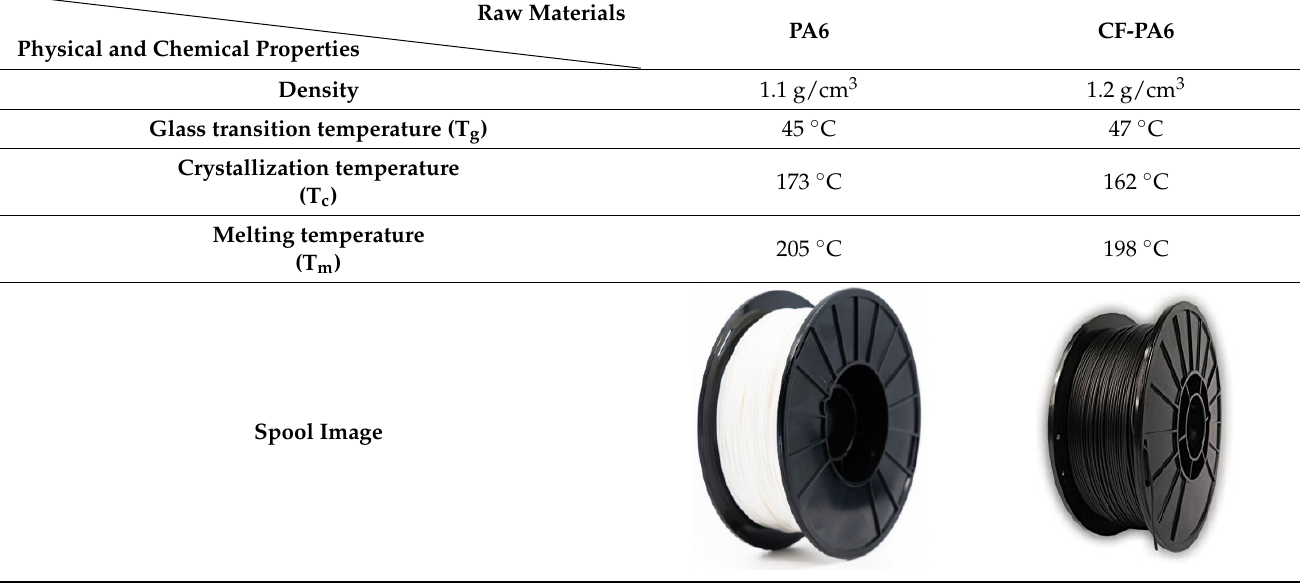
Table 1. The characterizations of the utilized raw materials.